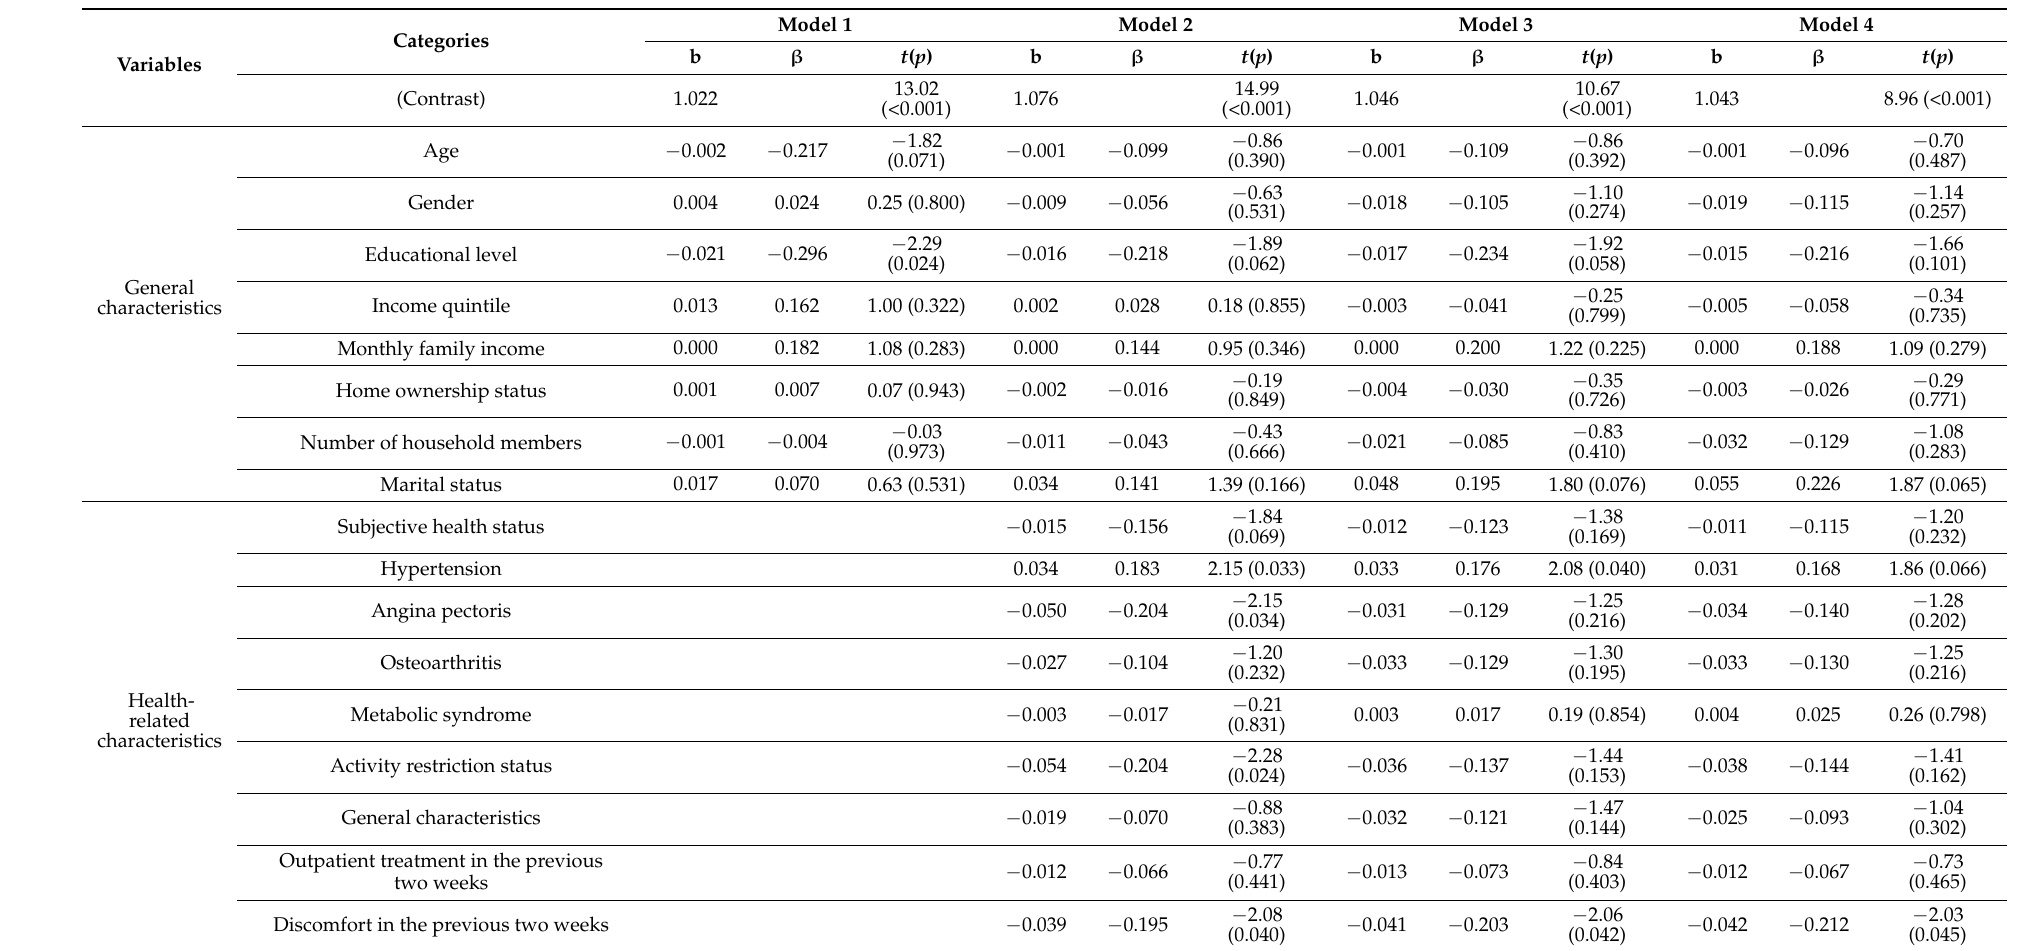
Table 4. Factors influencing health-related quality of life of working cancer survivors, n =